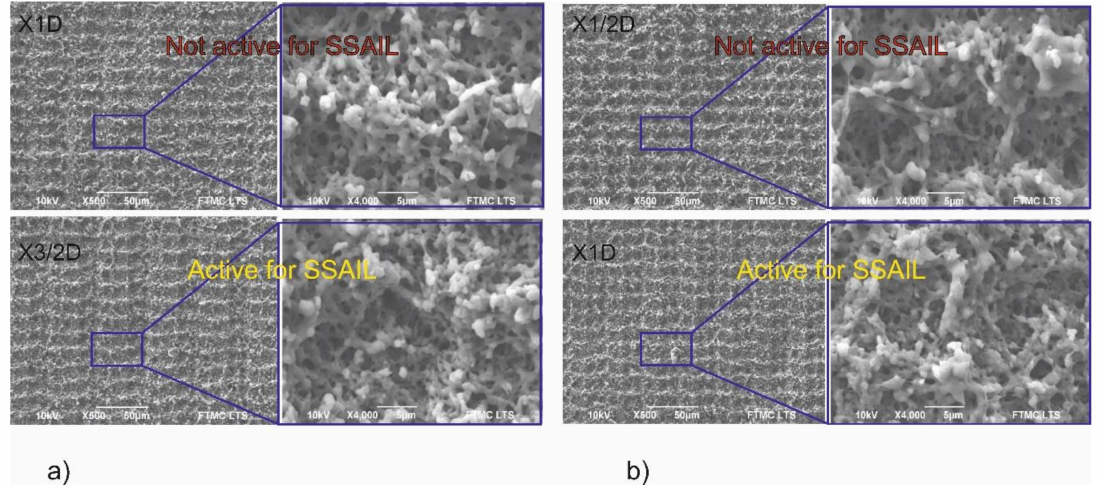
Figure 12. SEM image of PC / ABS surface processed with picosecond laser applying ( a ) 15 W and ( b ) 10 W average laser power. “X1D”, “X3 / 2D” and “X1 / 2D” indicate the method of laser writing, as described in the experimental